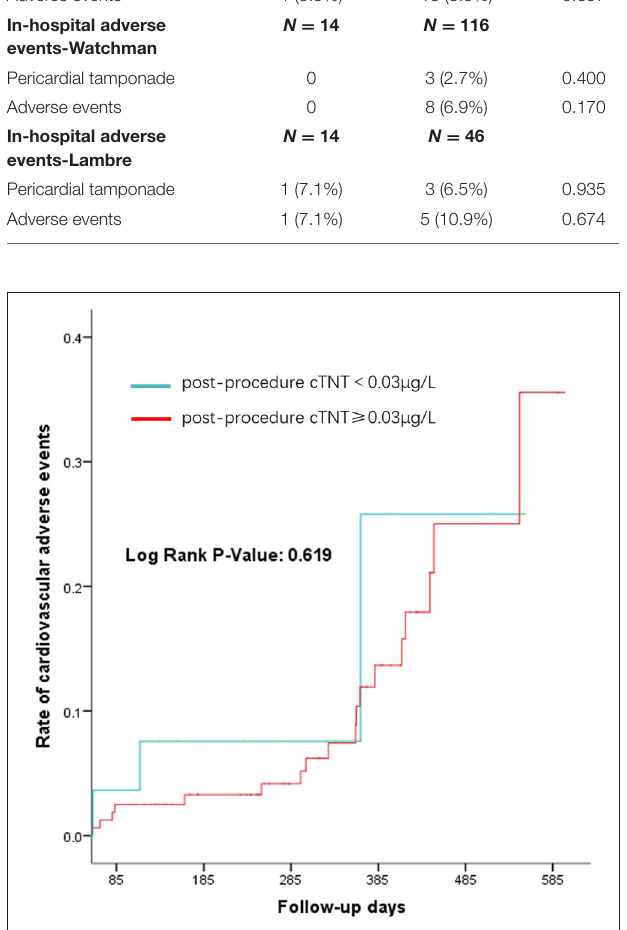
FIGURE 2 | Long-term cardiovascular events after left atrial appendage occlusion (LAAO).